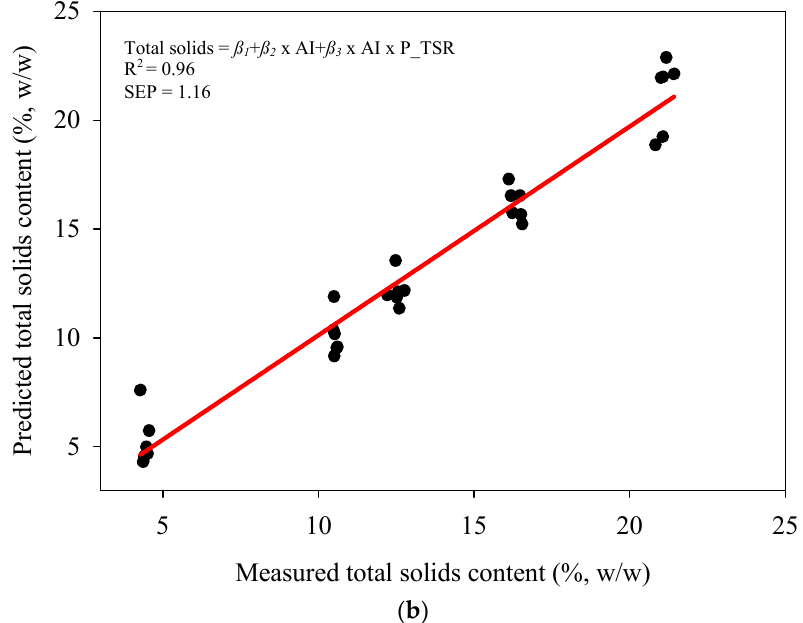
Figure 6. ( a ) Predicted versus measured protein content of MPC85 and sMPC samples of 4–21% TS. ( b ) Predicted versus measured total solids content of MPC85 and sMPC samples of 4–21% TS. AI, acoustic impedance measured using an inline acoustic flowmeter; P_TSR, protein to TS ratio: R 2 , coefficient of determination; SEP, standard error of prediction.